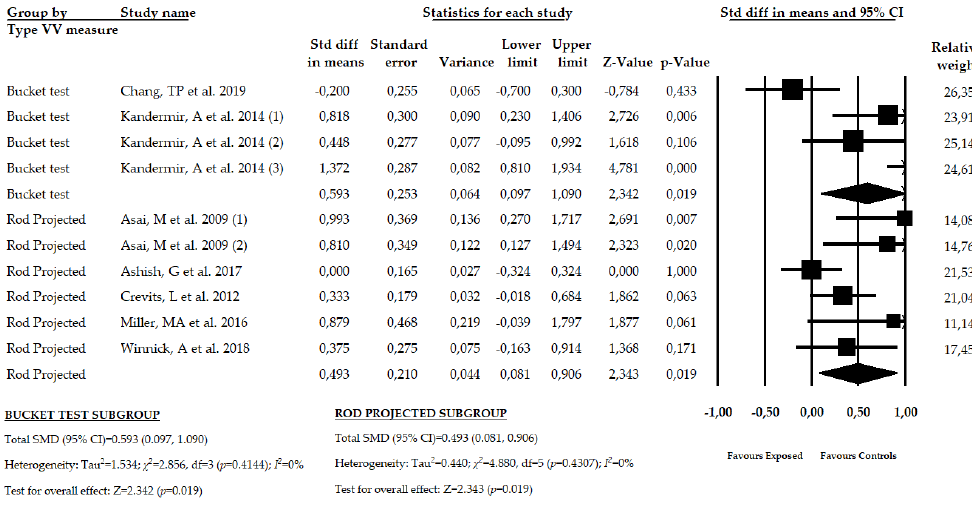
Figure 6. Forest plot for the subgroup analysis in patients with PHD using the bucket test or rod projected test in a dark room to measure the SVV . projected test in a dark room to measure the